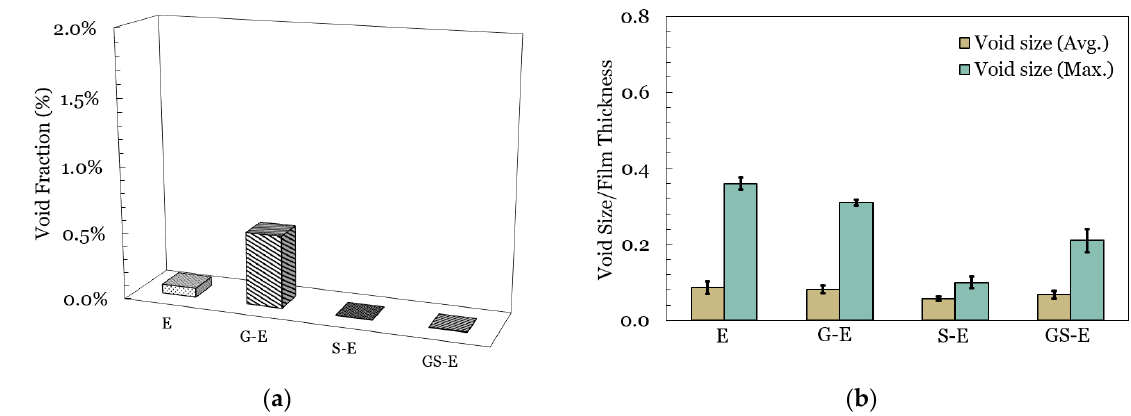
Figure 7. Summary of micro-CT scan results, ( a ) void fraction, and ( b ) size of the voids.